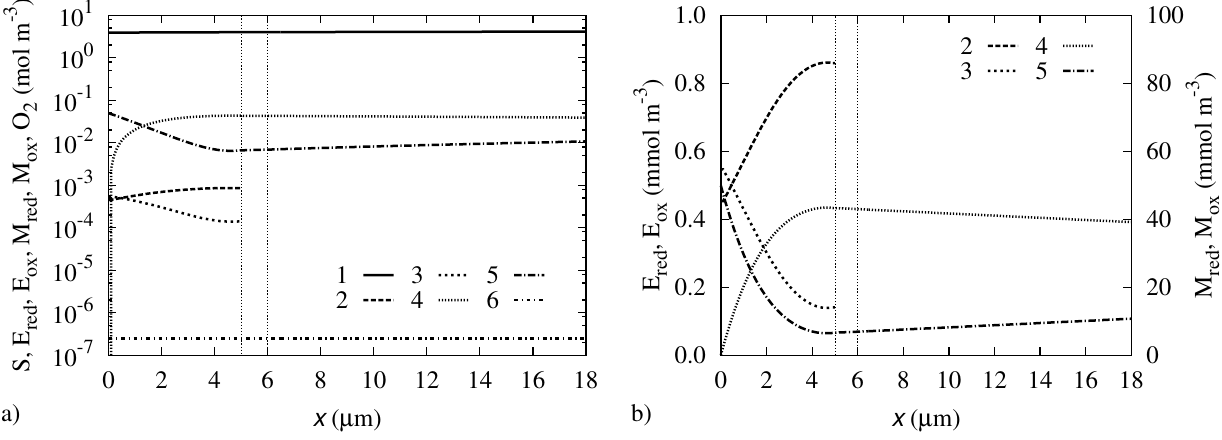
Figure 4. The concentration profiles of S (1), E at the steady state. Vertical axes correspond to the concentration of species, horizontal axes correspond to the distance from an electrode surface. The vertical lines mark the boundaries of the biosensor layers. Concentrations in graph (a) are provided in logarithmic scale. In graph (b) concentrations of four species are depicted on a linear